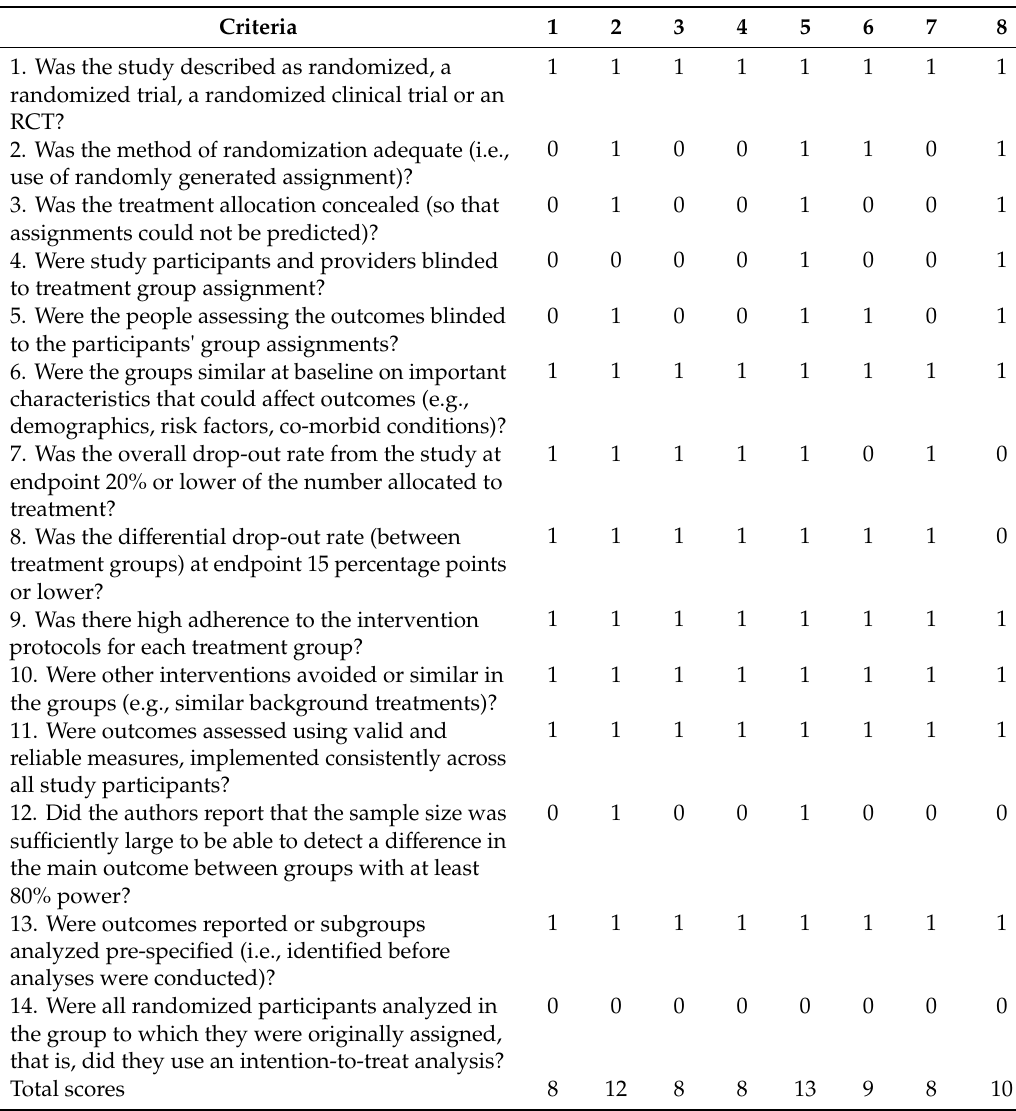
Table 4. Study Quality